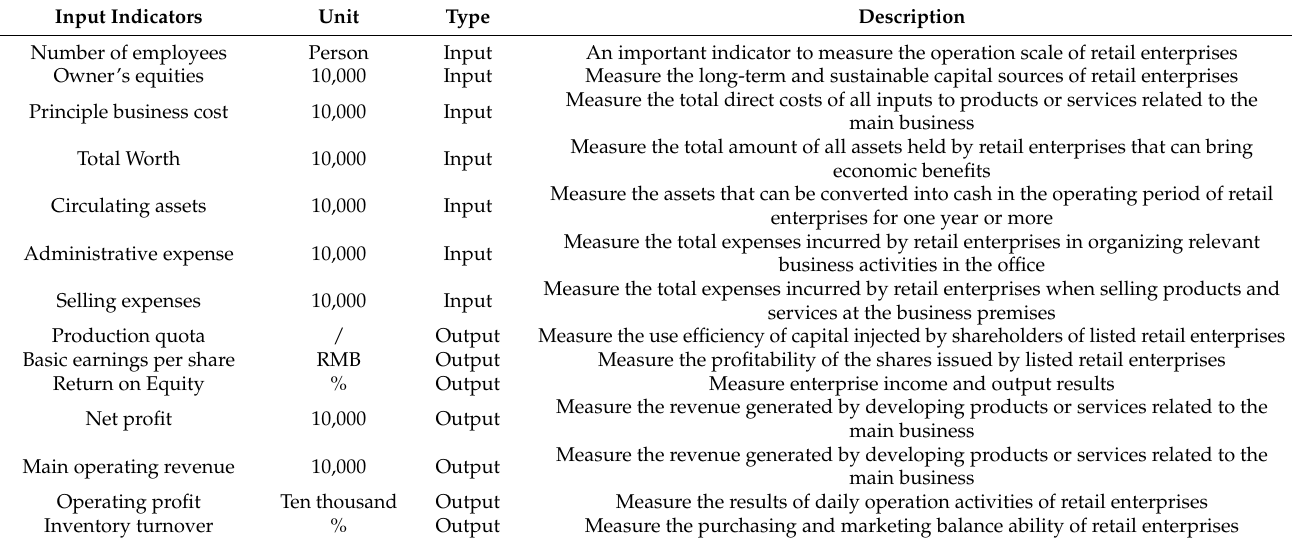
Table 1. Primary Input-output Index System.